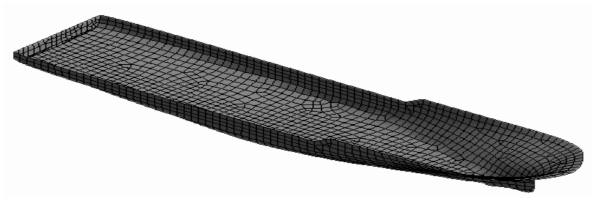
Figure 3. Finite element meshing of the